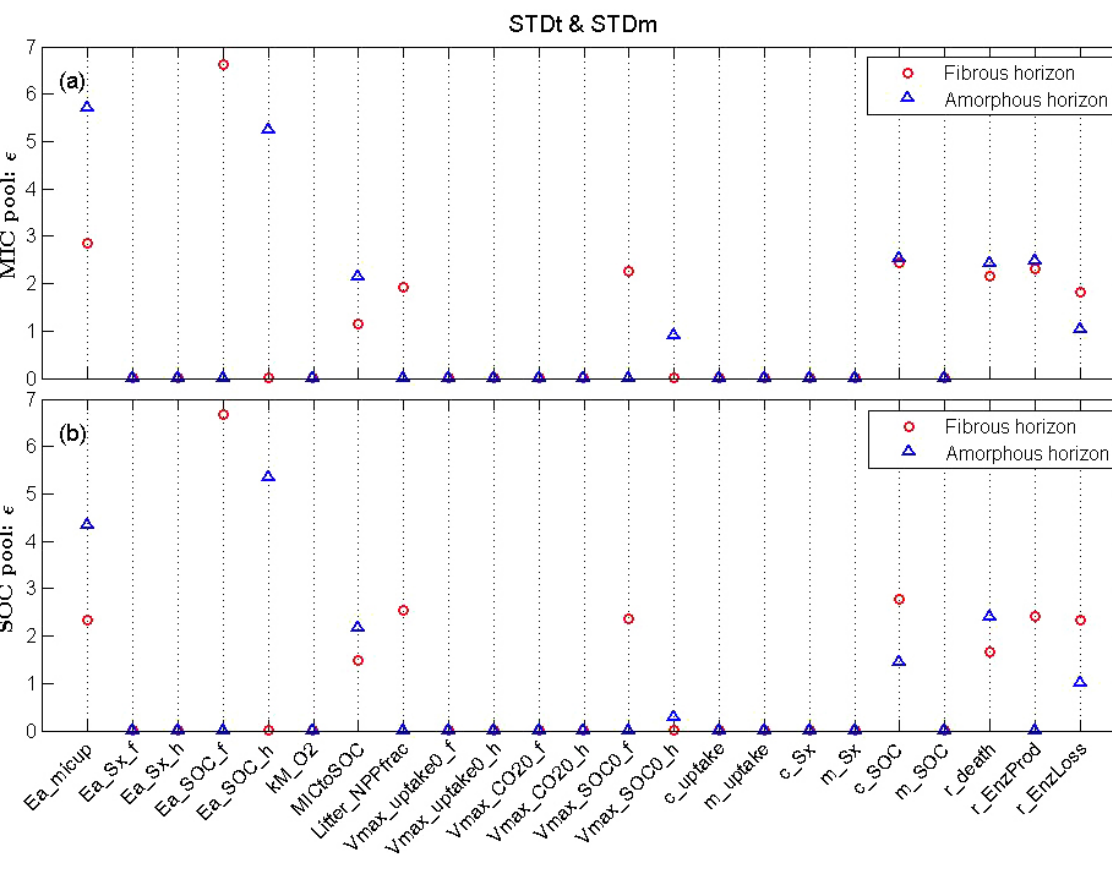
Figure 4. Screening test results (sensitivity index ε = (SOC) under a standard soil temperature and moisture (STDt and STDm)